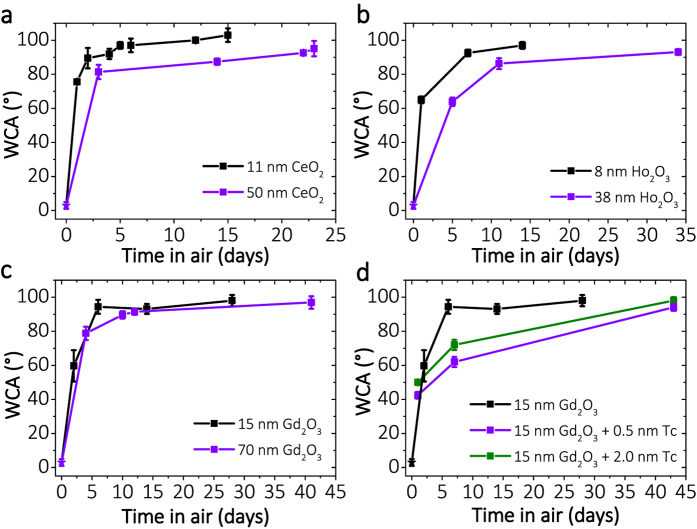
Time-dependent evolution of hydrophobicity in air of pure RE oxide and adsorbate-modified RE oxide surfaces.Water contact angle (WCA) measurements for two different thicknesses of (a) CeO2, (b) Ho2O3, (c) Gd2O3 and (d) thin films of tetracene at Gd2O3 surfaces (compared to native Gd2O3). Low WCA values are measured within the first 24 h after film preparation. The contact angle increases with increasing exposure time. This provides evidence for a slow adsorption mechanism modifying the surface coverage and contact angle. The stars denote the ‘initial’ WCAs, measured directly (within 1 min) after annealing aged films to 600 °C (see text). Each WCA curve exhibits two different slopes (‘steep’ within the first 7 days and ‘less steep’ afterwards) evidencing process which involves either two different kinetic regimes of the same or two different processes and/or more than one involved compound (see XPS discussion).